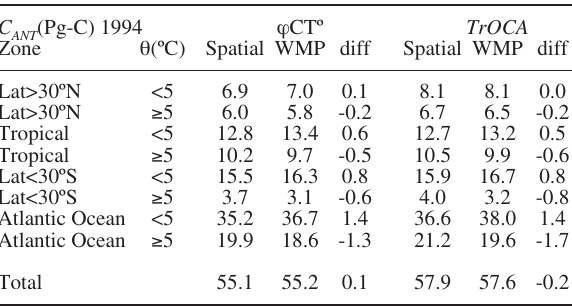
Table 2 . – C inventories (Pg-C) in the Atlantic and in different ANT latitudinal bands and layers using the TrOCA and j CTº methods.